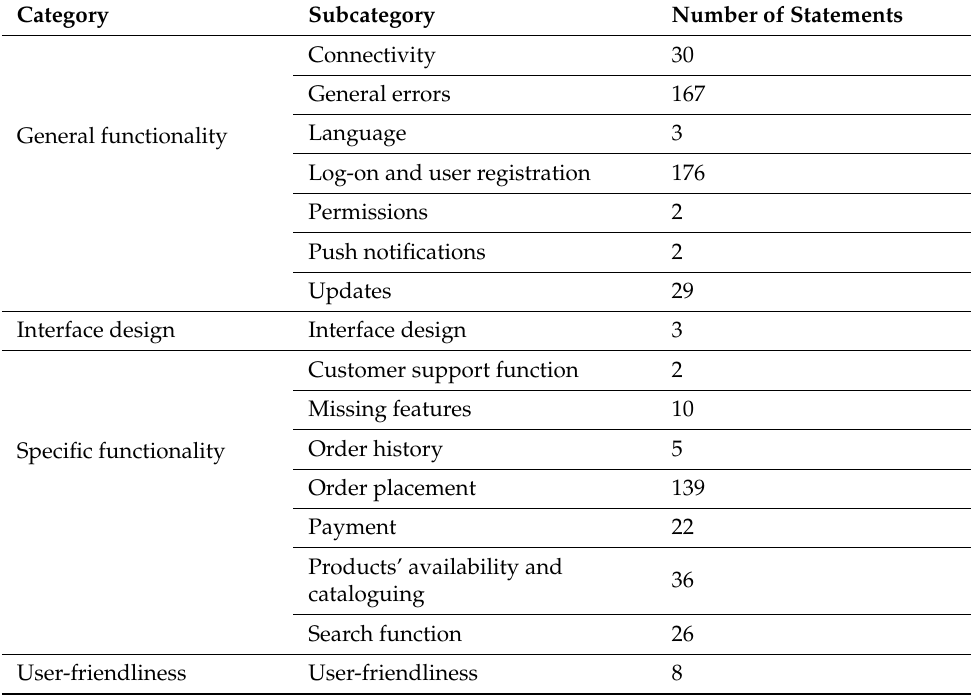
Table 2. Categories of MGSAs’ identified